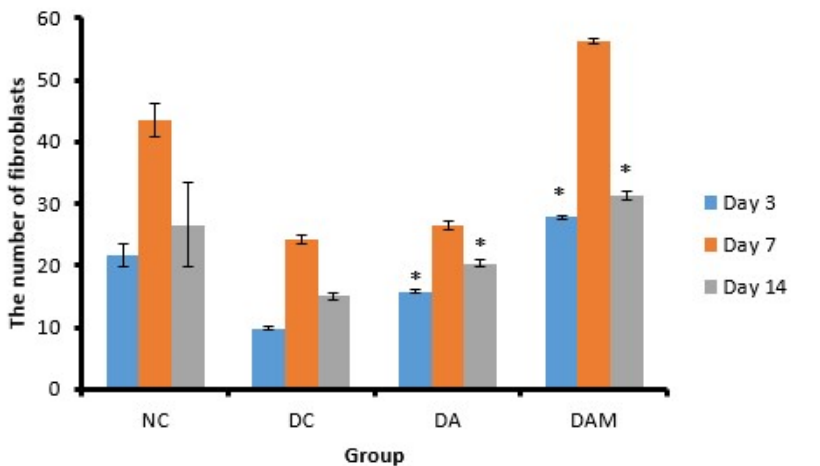
Figure 9. Number of fibroblasts at the three variation times. Notation on the graph shows the result of the statistical test ( α < 0.05). * notation shows insignificant differences with NC but significant differences with DC. * = 0.01 ≤ α < 0.05. NC: normal group; DA: alginate treatment group; DAM: alginate–mangosteen rind extract treatment group; and DC: diabetic group.